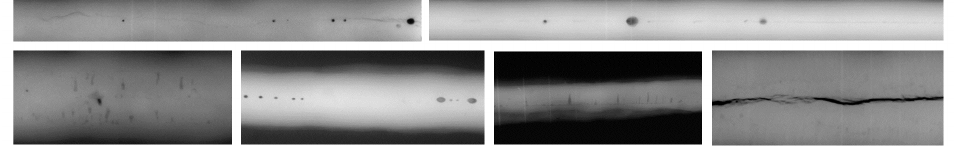
Figure 1. Examples of defects in images. The challenge of defect detection in images is the existence of tiny cracks and noisy patterns in